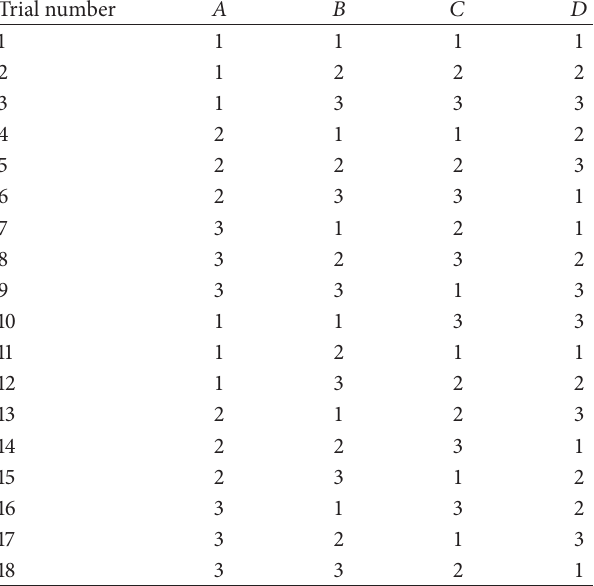
Table 2: 𝐿 18 orthogonal